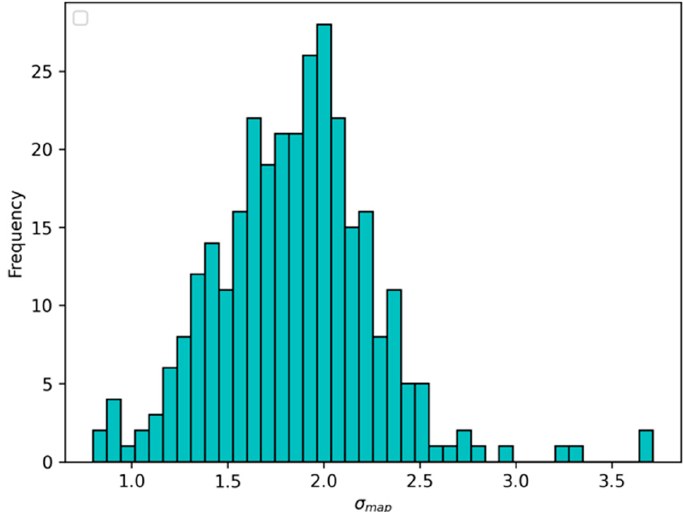
Figure 7. Gaussian distribution of σ map samples.